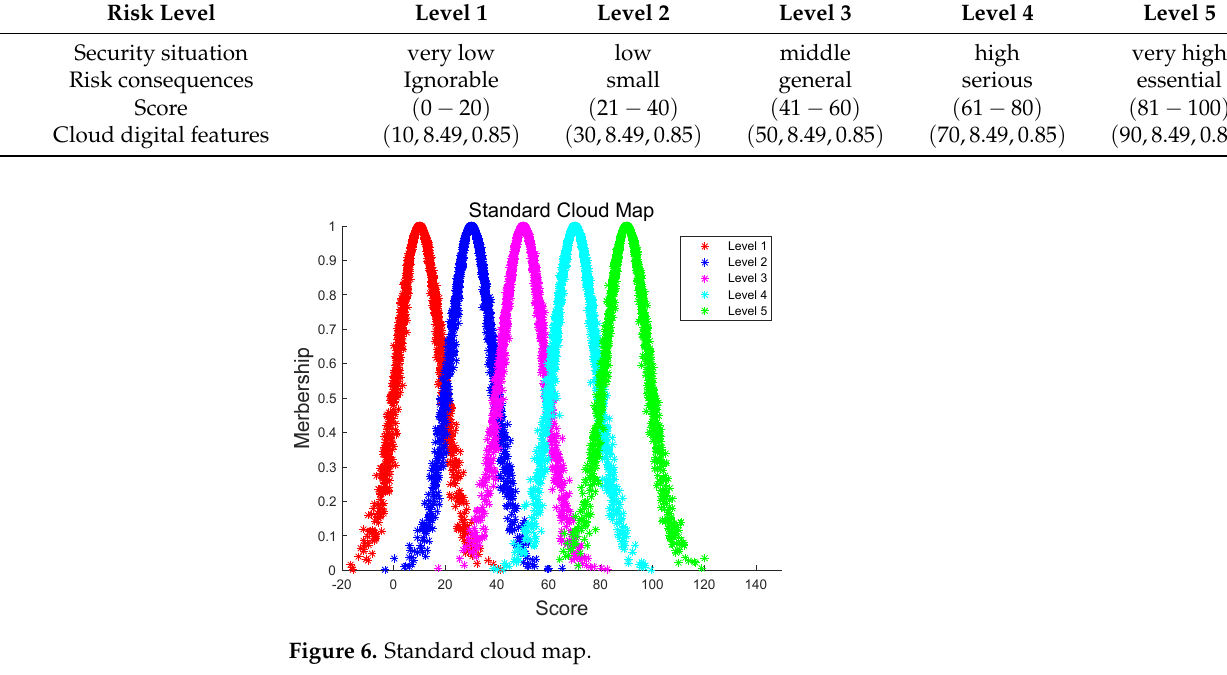
Table 5. Weights and cloud numerical feature results. First-Level Indicator